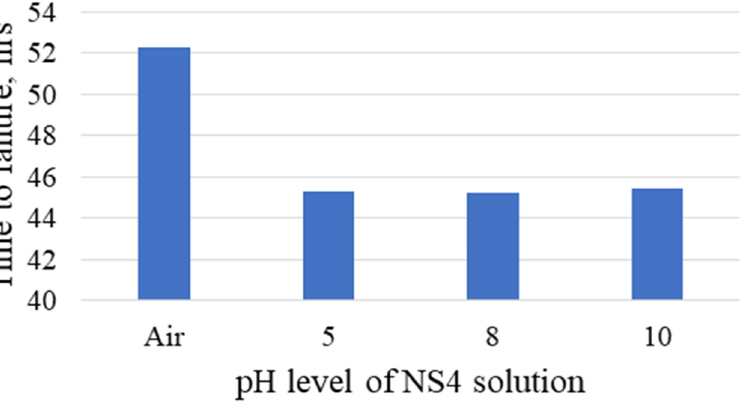
Figure 10. Variations in time to failure of the exposed X52 carbon steel in air and the different NS4 solution pH level. Data from [67].